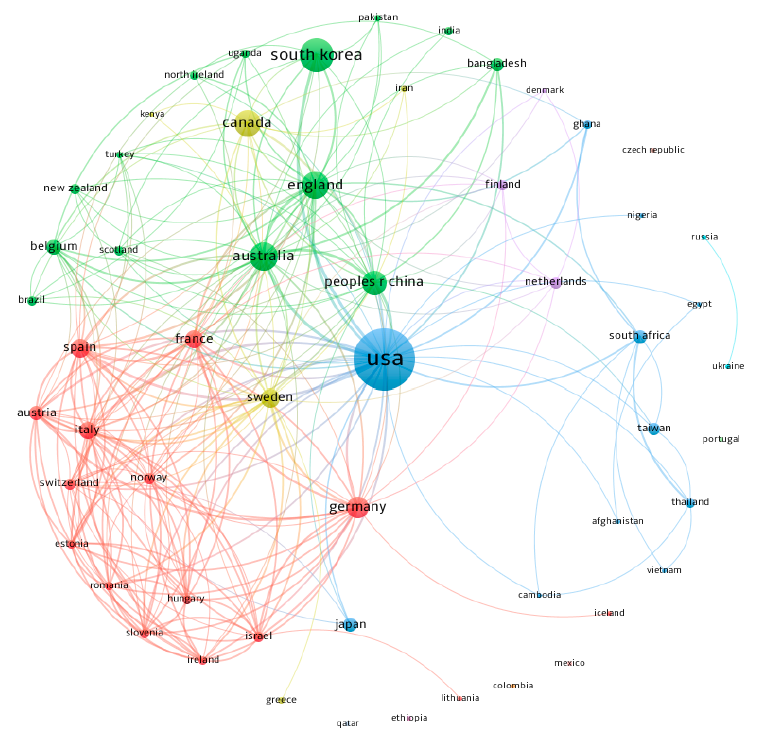
Figure 4. Co-authorship networks by countries/regions.